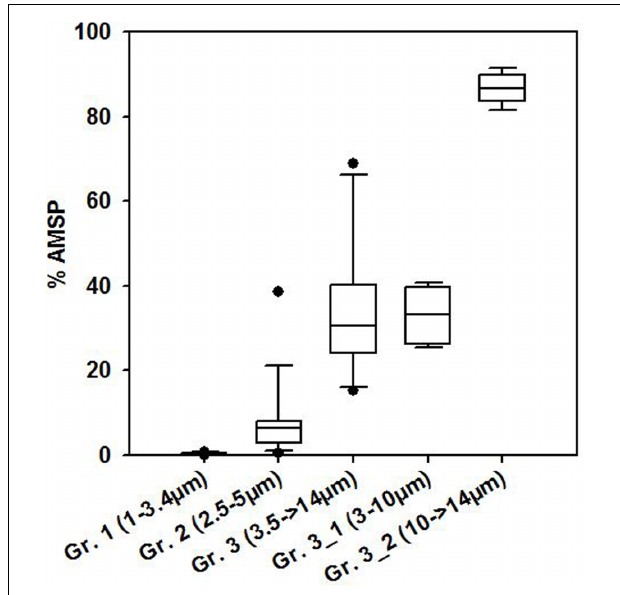
FIGURE 3 | Boxplot showing average percentages of AMSP for the different NCry-SP groups (Gr.) distinguished on the flow cytometer in summer. The data was pooled for all time points sampled at all three study sites during both summer sampling dates.